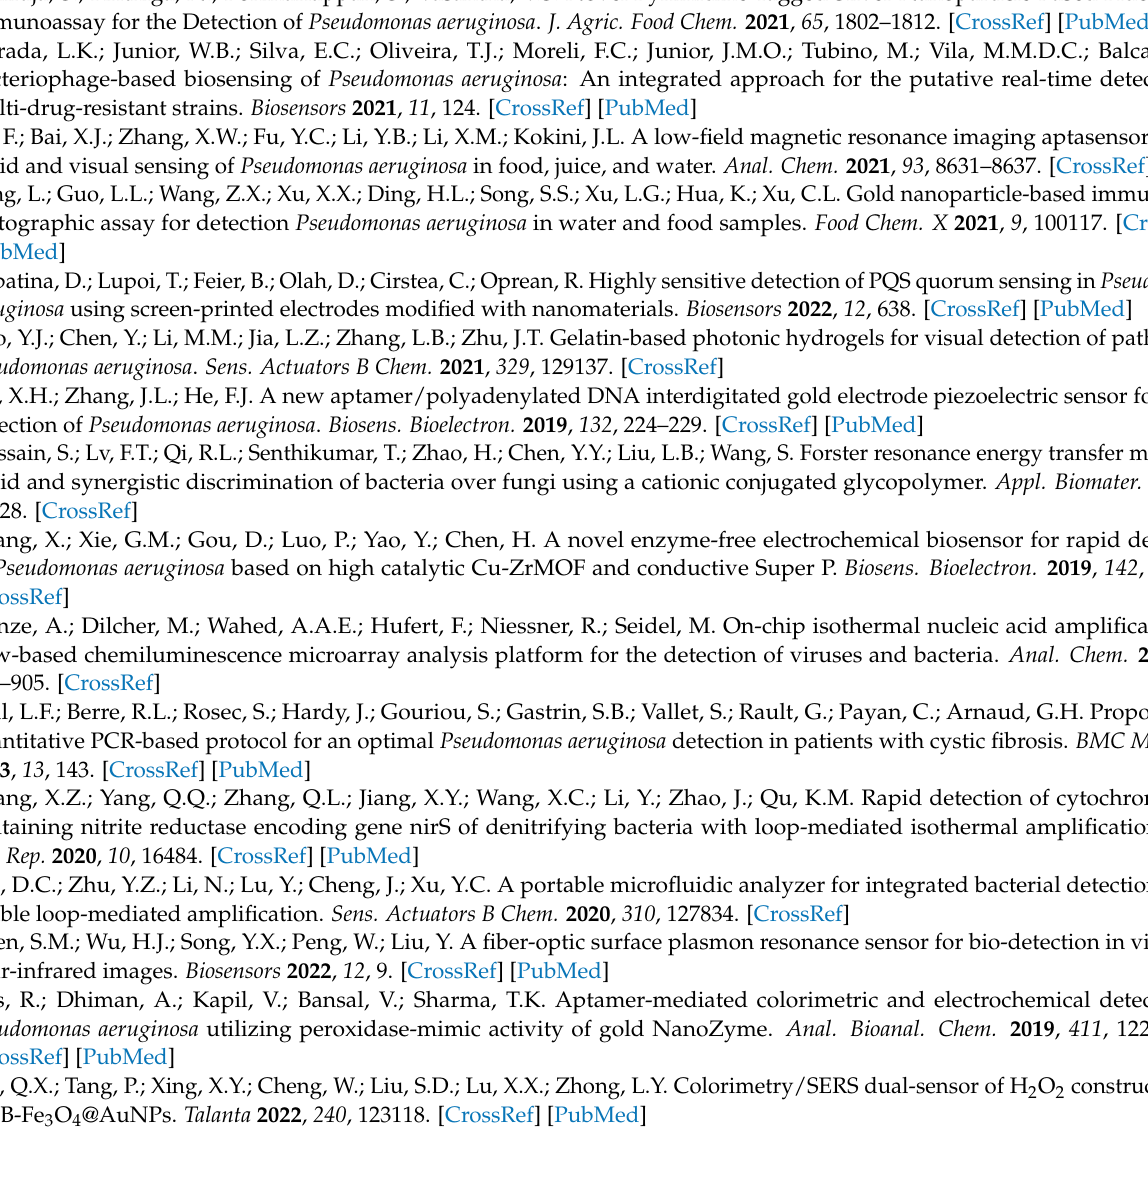
patina concentration between 1 and 10 8 CFU · mL − 1 . Figure S5: The relationship between absorbance and time in the colorimetric sensor. References [46,47] are cited in Supplementary